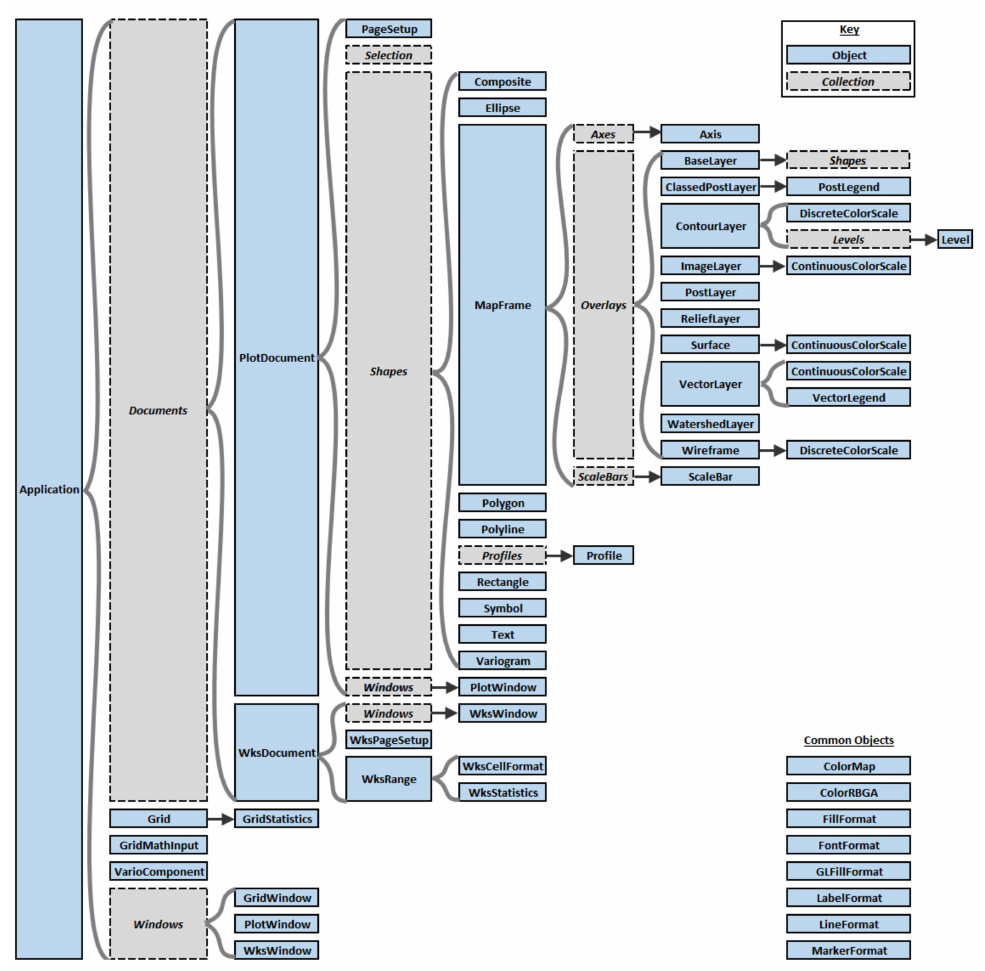
Figure 7. Surfer automation object model [19], including collection objects (gray boxes) and objects (blue